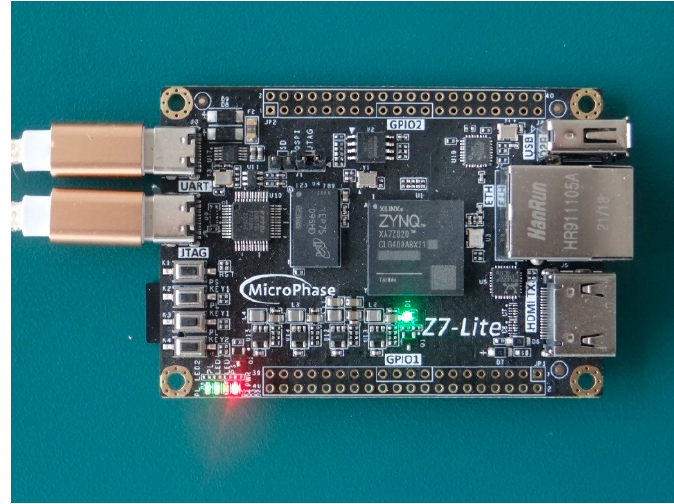
Figure 14. ZYNQ-7020 experimental platform.